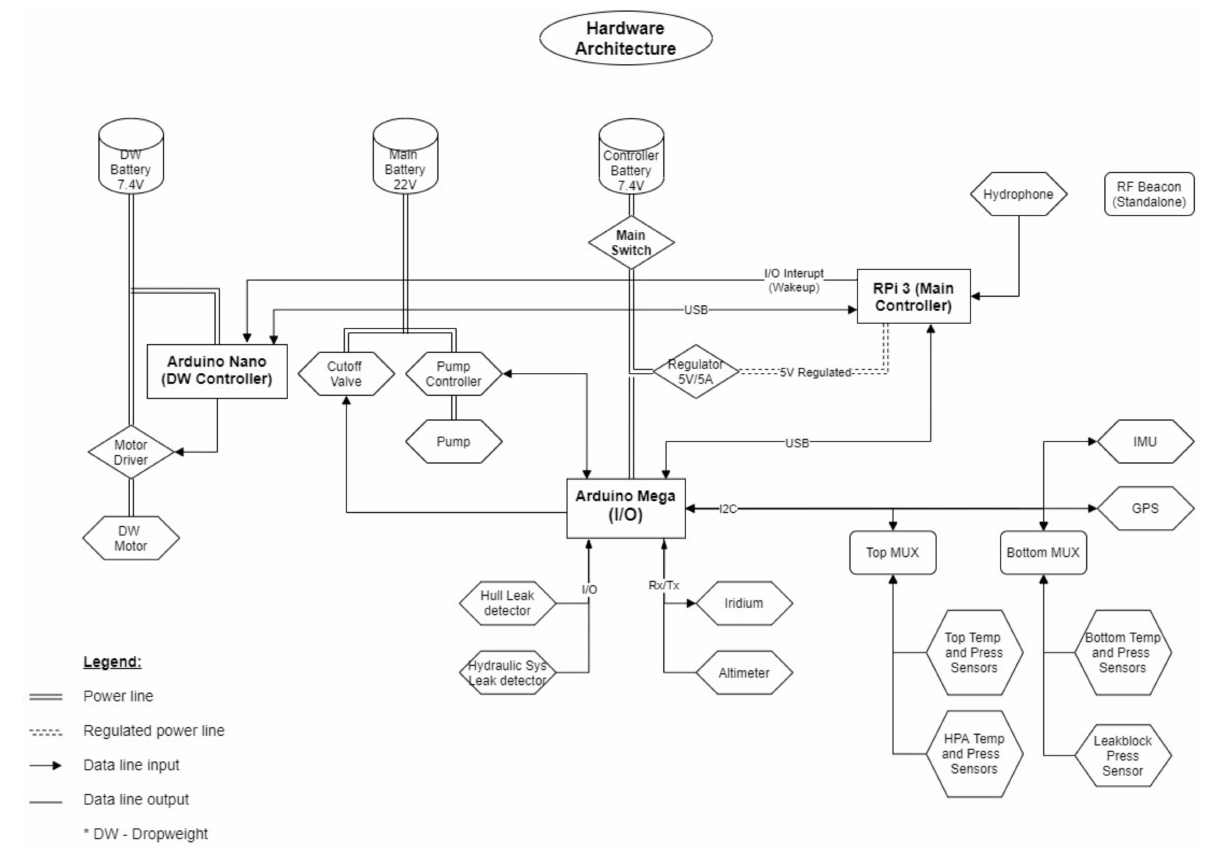
Figure 2. Hardware